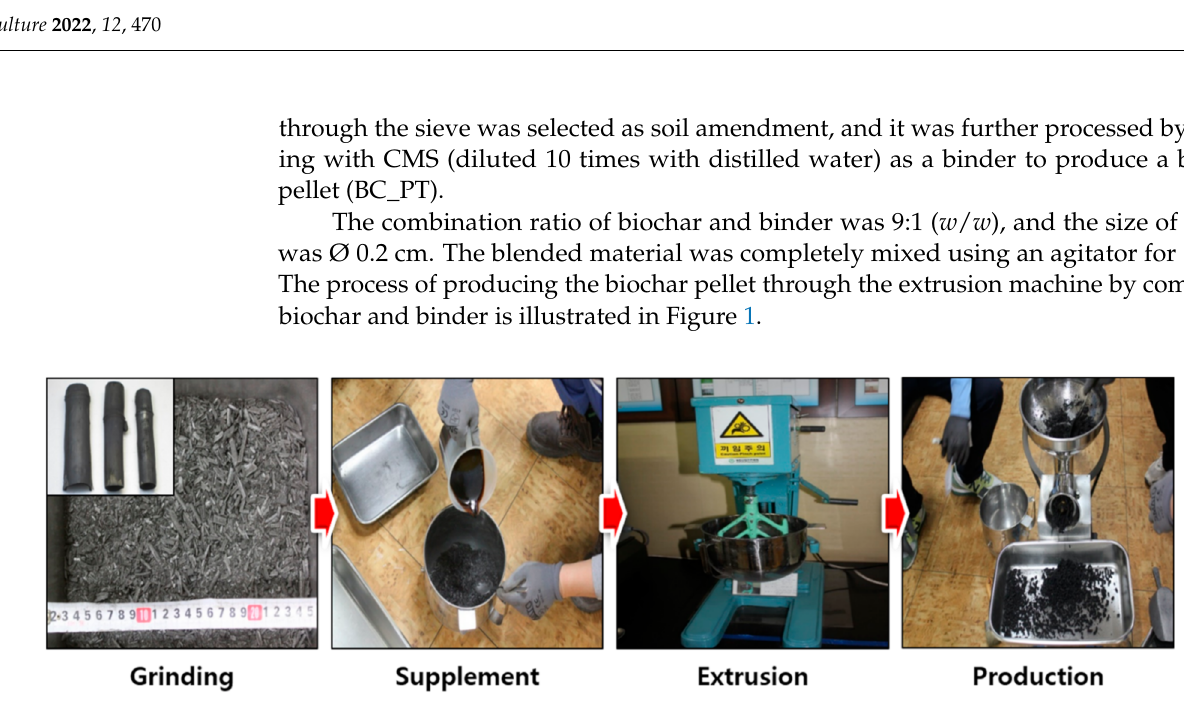
Figure 1. Manufacturing process of pelleted biochar (BC_PT) using bamboo biochar.